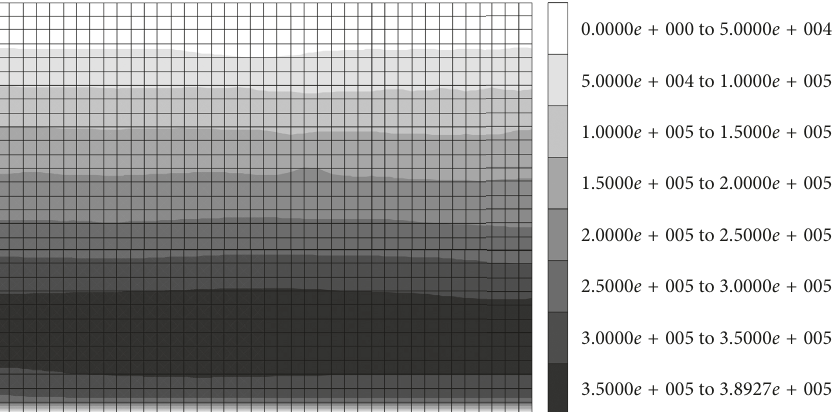
Figure 10: Contour of the pore